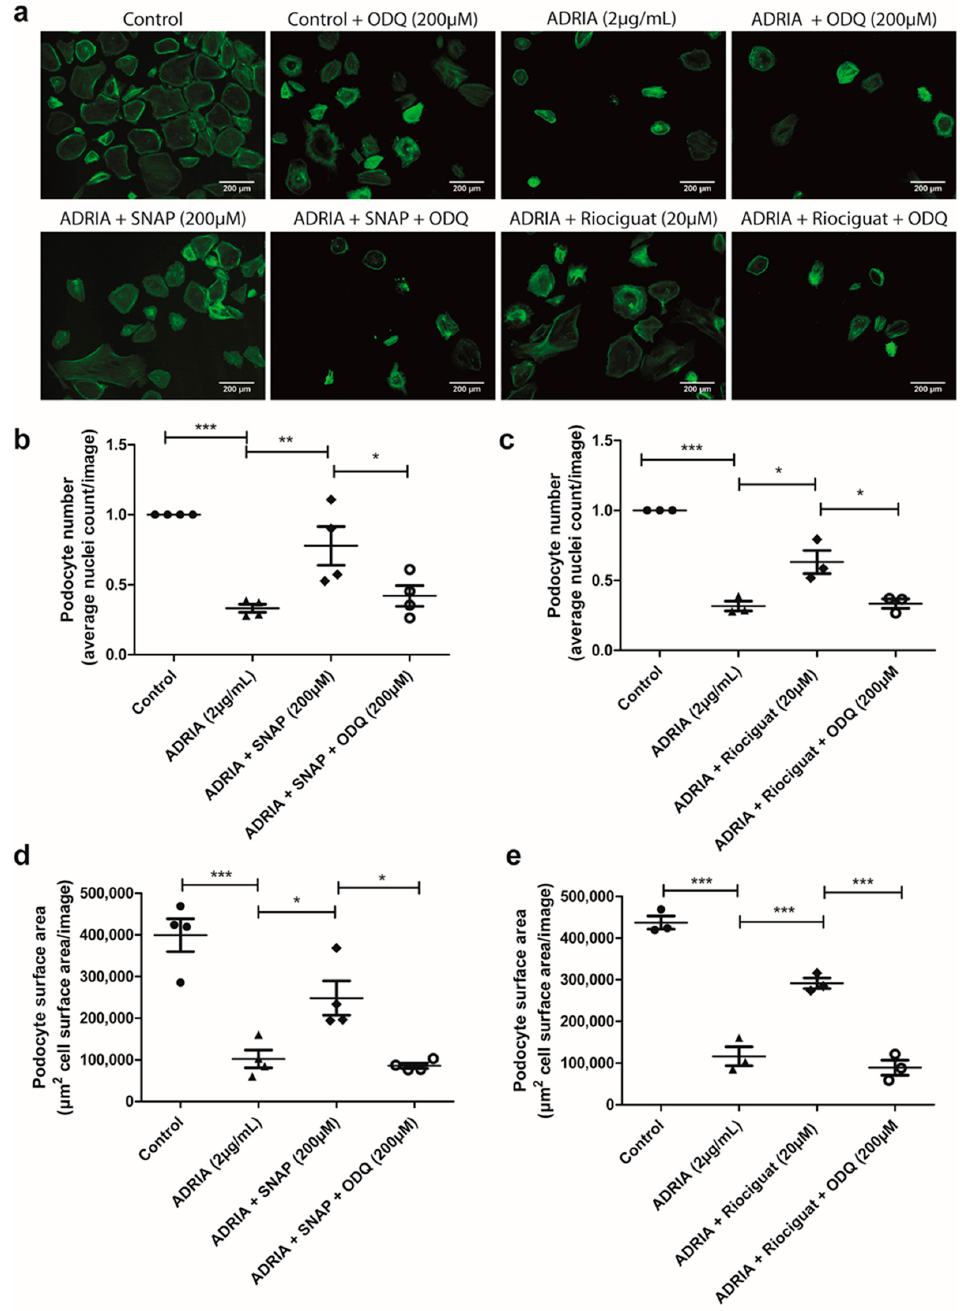
Figure 6. Riociguat and SNAP prevent Adriamycin-induced podocyte injury specifically by stimu- lating sGC. hPOD were treated for 24 h with 2 µg/mL Adriamycin to induce podocyte injury. Podo- cytes were simultaneously treated with either 20 µM Riociguat or 200 µM SNAP with or without 200 µM ODQ. Podocytes were subsequently stained with Phalloidin-FITC and Hoechst 33342. ( a ) Representative pictures are shown for all conditions. ( b ) Quantitative analyses in FIJI for average cell count for SNAP without or with ODQ and ( c ) Riociguat without or with ODQ treatment or total cell surface area per image for ( d ) SNAP without or with ODQ or ( e ) Riociguat without or with ODQ. * p < 0.05 ** p < 0.01 *** p < 0.001.